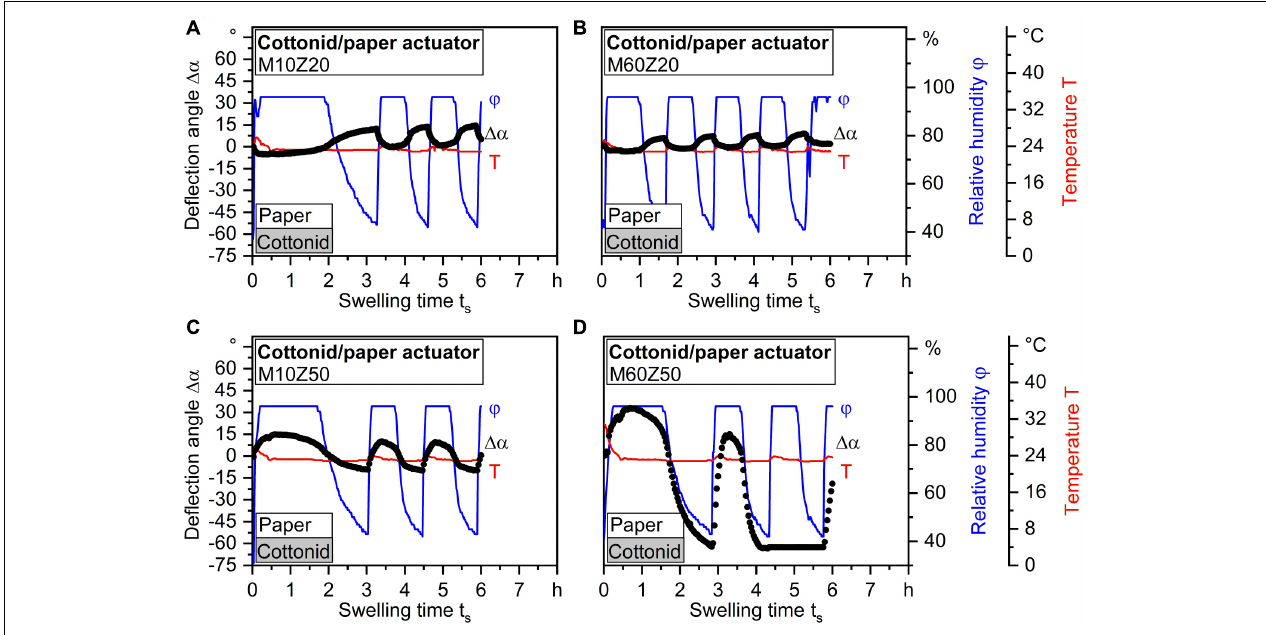
FIGURE 5 | Cyclic actuation test (Deflection angle (cid:49) α vs. swelling time t s ): (A) M10Z20, (B) M60Z20, (C) M10Z50, and (D) M60Z50.